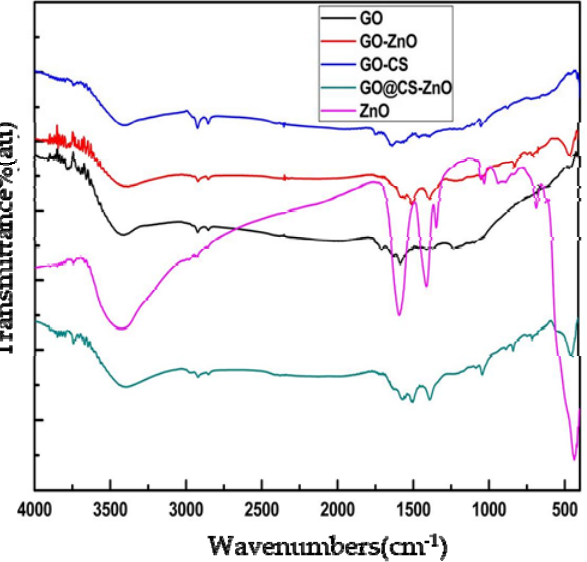
Figure 1. FTIR spectra of nanomaterials (GO, GO/ZnO, GO–CS, GO–CS/ZnO, and ZnO).